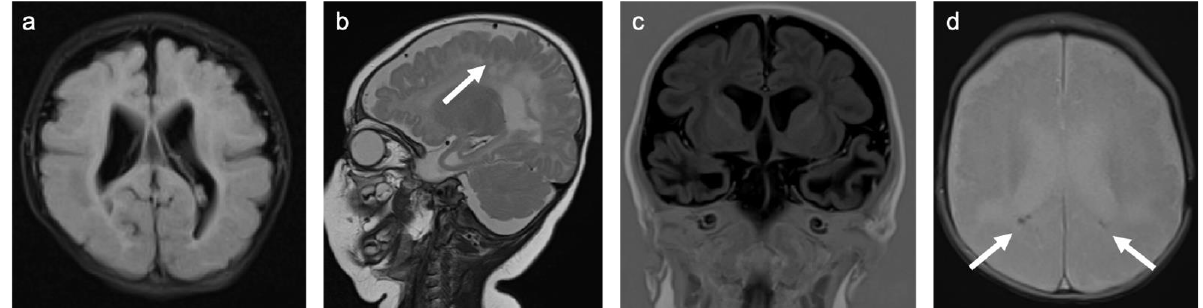
Figure 7. Representative case “Infectious white matter damage”: congenital cytomegalovirus infec- tion. FLAIR ( a ), T2W ( b ), Turbo inversion recovery (TIR; ( c )), and T2*W ( d ) sequences. Four-month- old girl with a history of congenital cytomegalovirus infection. MRI shows microcephaly with polymicrogyria (( b ); white arrow), bilateral ventriculomegaly ( a – d ), global thinning of the cerebral mantle, especially temporal ( b , c ), bilateral white matter signal abnormalities in the frontal and parieto-occipital regions ( a ), and punctuate periventricular calcifications (( d ); white arrows).